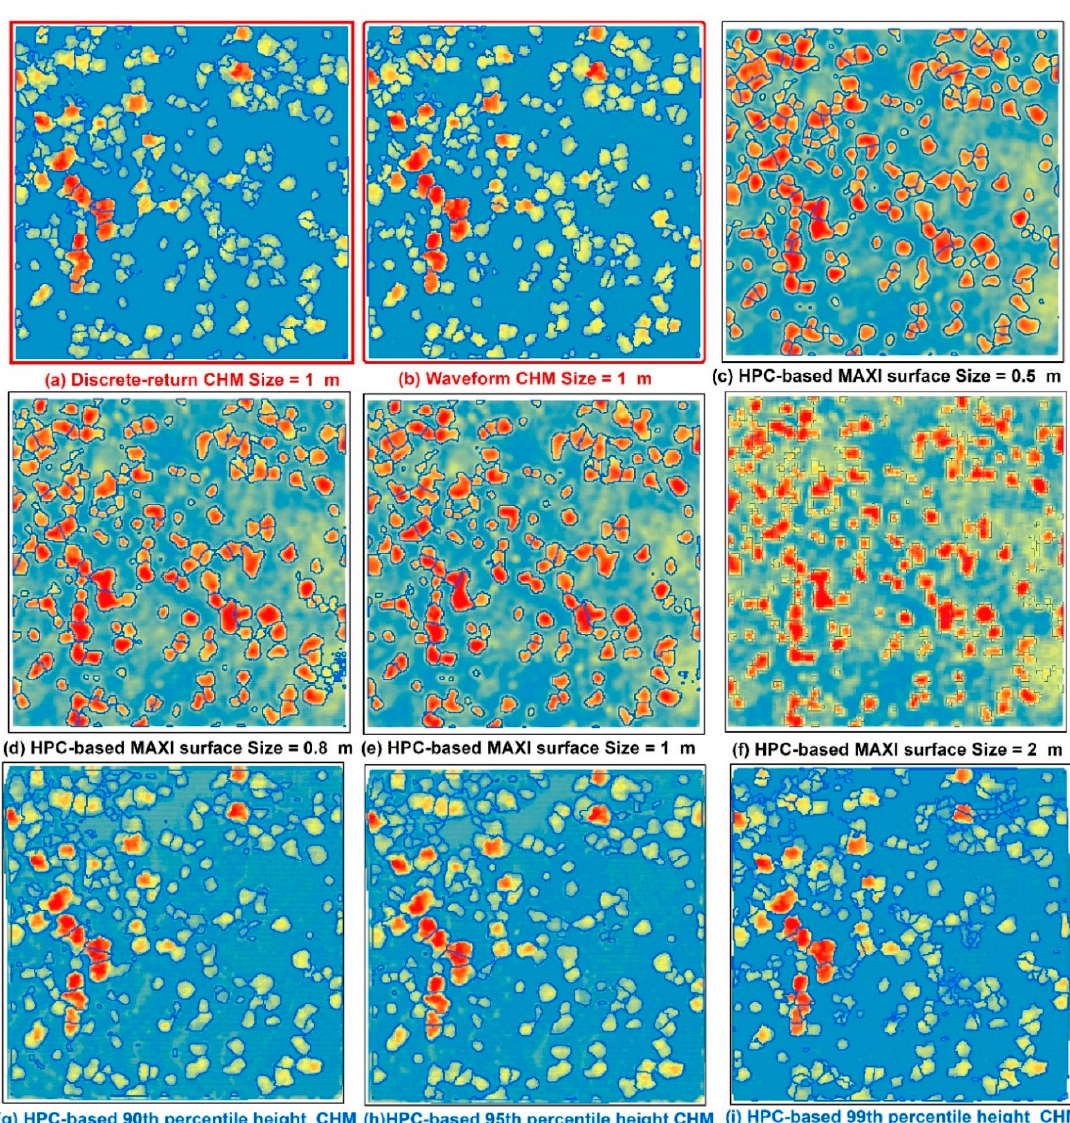
Figure 9. Tree crown segmentation results using ( a ) discrete-return, ( b ) waveform-based CHMs (red), HPC-based intensity surfaces with different grid cell sizes ( c ) 0.5 m, ( d ) 0.8 m, ( e ) 1 m, and ( f ) 2 m (black), ( g ) HPC-based 90th PH, ( h ) 95th PH, and ( i ) 99th PH CHM (blue) over the subset region.